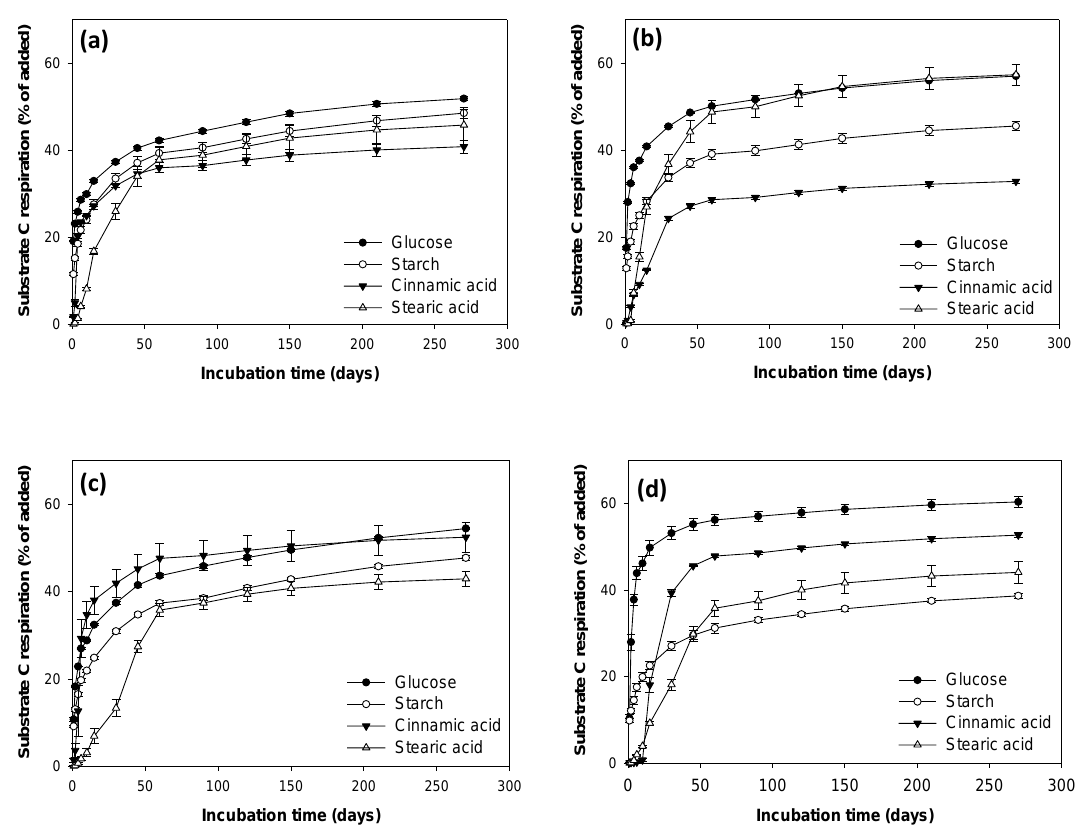
Figure 1. Substrate C respiration in response to the addition of four substrates in Mollisol (a) , Ultisol (b) , Andisol (c) , and Gelisol (d) . Symbols represent proportion of added substrate C respired at each sampling time along with standard error bar ( n =